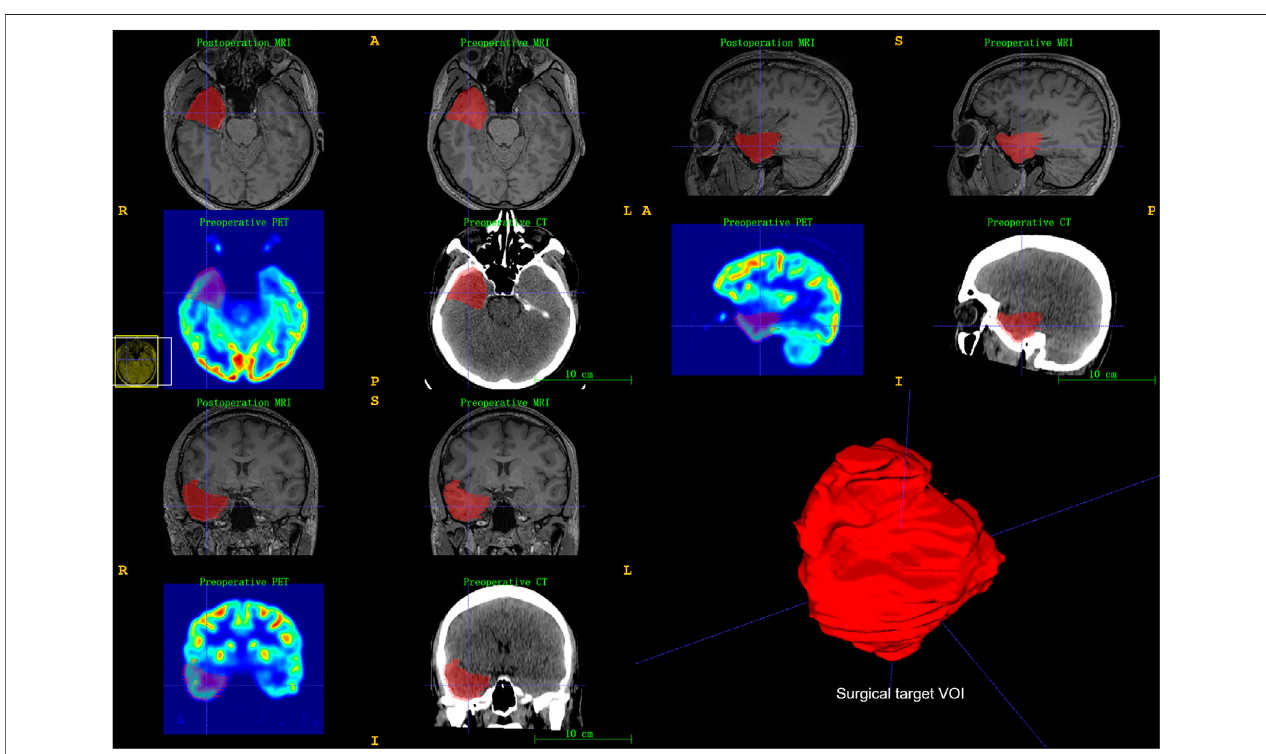
FIGURE 1 | Illustration of surgical target brain volume of interest (VOI) segmentation. Registration of pre-/postoperative neuroimaging and then used ITK-SNAP software to segment surgical target VOI. Surgical records further re fi ned fi nal target VOI.